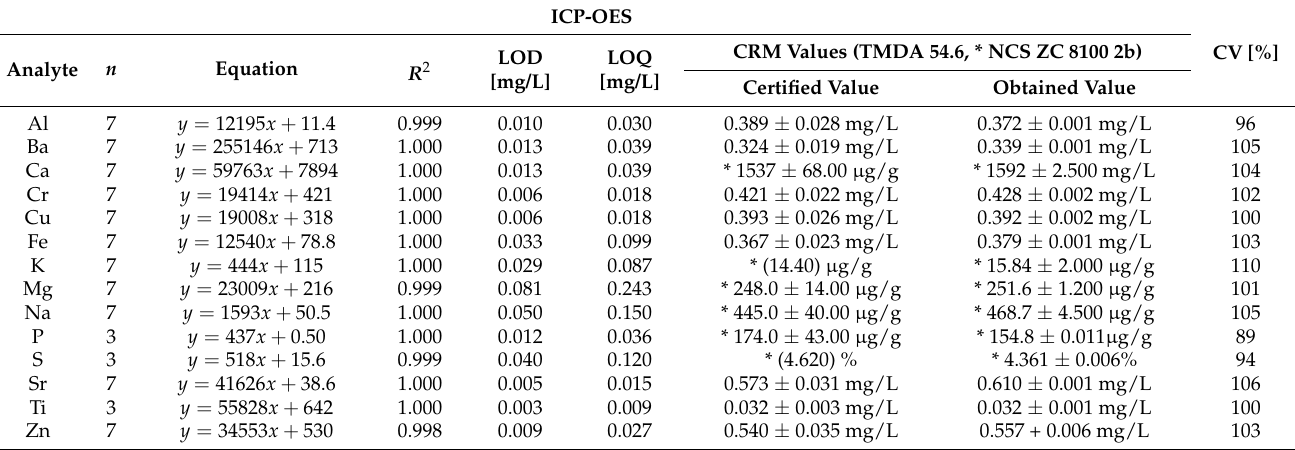
Table 12. Basic validation parameters obtained for each analyte for the developed method ( n , number of standards in three replicates, R 2 , coefficient of determination, CRM’s